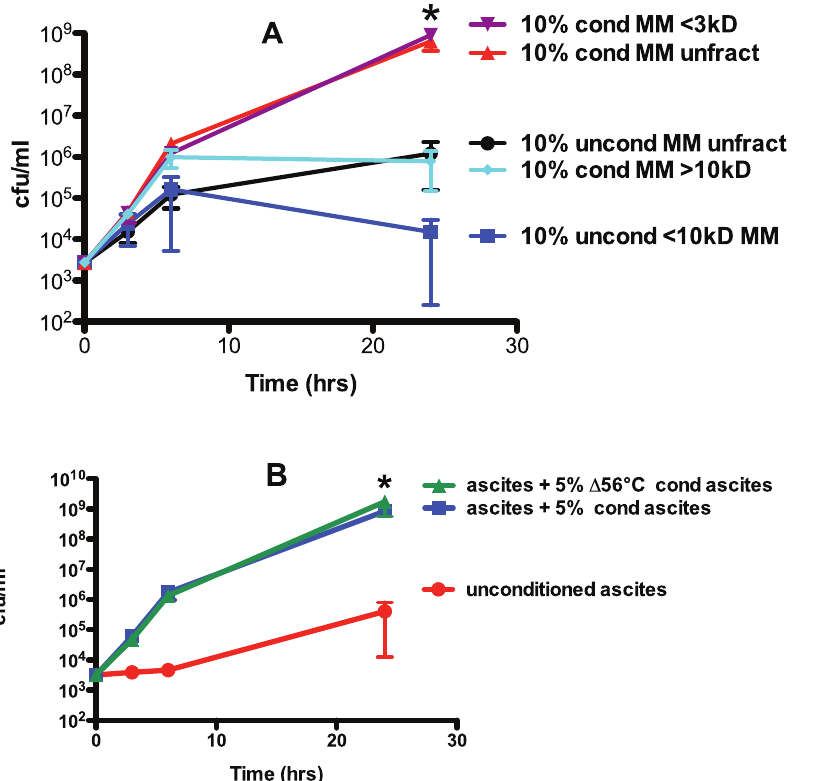
Figure 7. The mediators present in hvKP1 generated conditioned minimal medium and ascites that enhance the growth and/or survival of hvKP1 are , 3kD and heat stable. The growth of hvKP1 was assessed at 0, 3, 6, and 24 hours in human ascites (batch 2). Panel A: Ascites was supplemented with either hvKP1 generated conditioned (cond) M9 minimal medium (MM) (10% final concentration) that was: 1) non- fractionated (unfract), 2) , 3kD fraction, and 3) . 10kD fraction or unconditioned (uncond) minimal medium (10% final concentration) that was: 4) non-fractionated, and 5) , 10kD fraction. The growth and/or survival of hvKP1 was significantly increased when the ascites was supplemented with 10% conditioned, non-fractionated minimal medium or with 10% conditioned, , 3kD fraction of minimal medium compared to 10% unconditioned, non-fractionated minimal medium and 10% unconditioned, , 10kD fraction of minimal medium respectively (* P , 0.5/1). Data are Mean 6 S.E.M.; N=2-3. Panel B: Ascites was not supplemented (unconditioned) or supplemented with hvKP1 generated conditioned (cond) ascites or with hvKP1 generated conditioned ascites that was heated at 56 u C for 30 minutes ( D 56 u C) (batch 2) (5% final concentration for both supplements). The growth and/or survival of hvKP1 was significantly increased when ascites was supplemented with either conditioned or conditioned medium D 56 u C compared to unconditioned ascites (* P , 0.05/2). Data are Mean 6 S.E.M.; N=4.